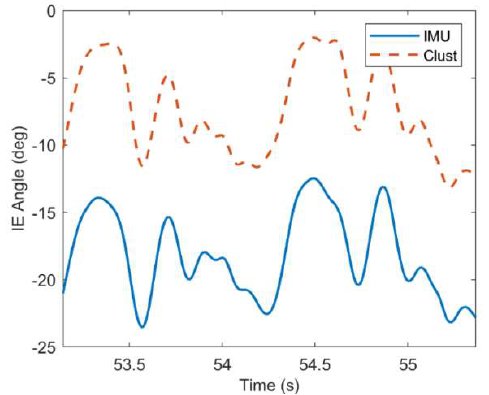
Figure 9. Magnified comparison of estimated right hip IE angle for representative subject in normal walking over two gait cycles. Comparison is between ErKF (IMU) and cluster (Clust) methods. Joint angle waveform characteristics, including stride to stride range of motion, estimated similarly despite offset.